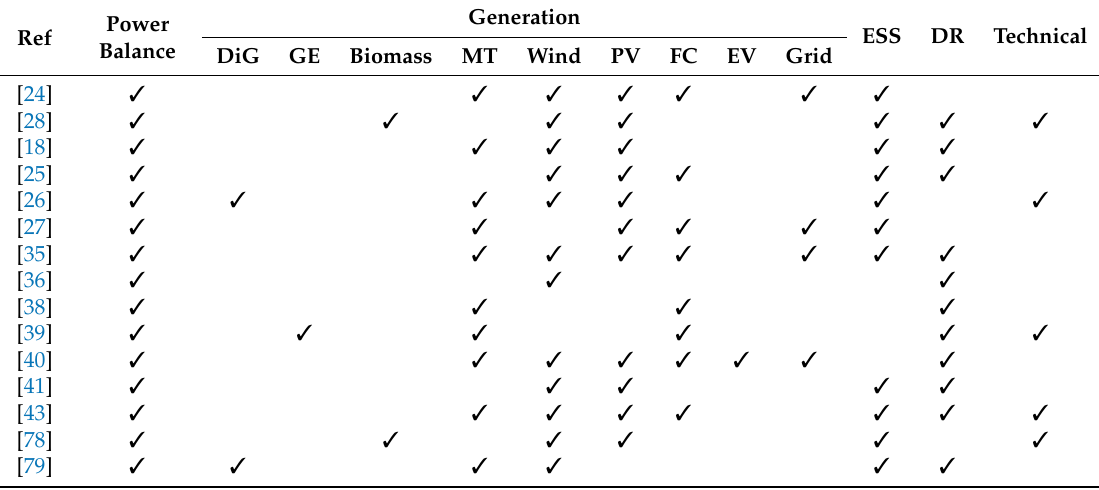
Table 3. Survey through collection of EMS